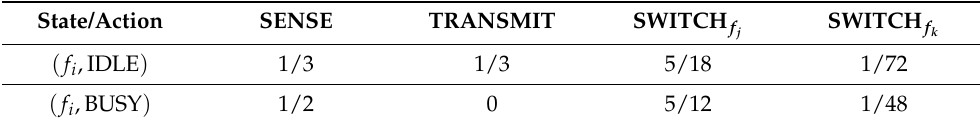
Table 4. Behavior policies